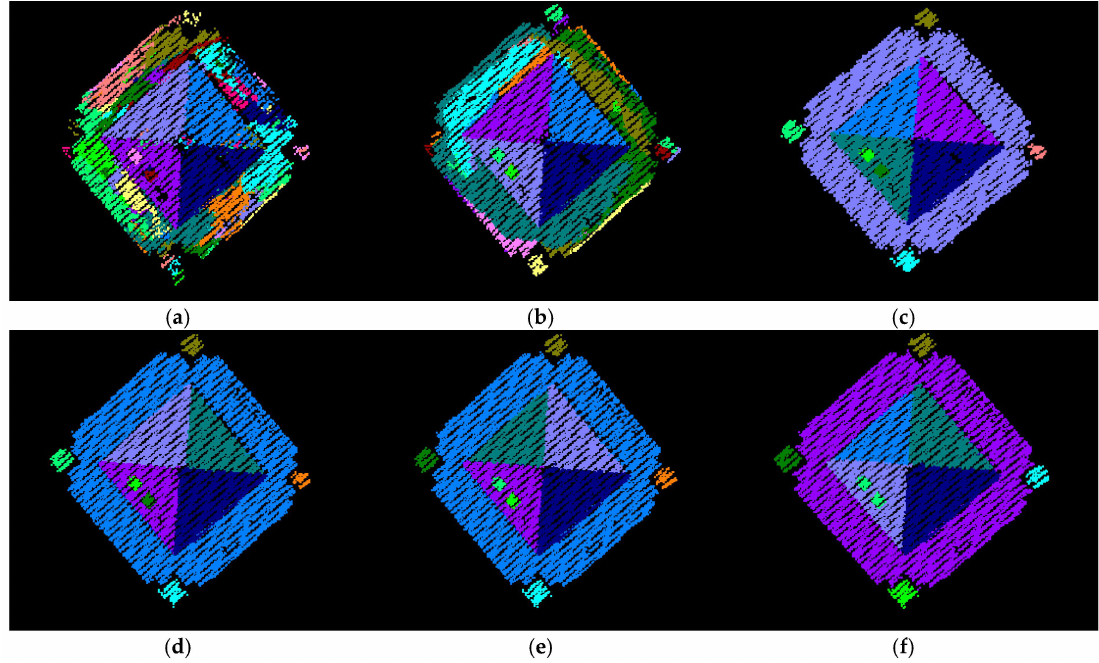
Figure 23. Segmentation results according to changing the accuracy of the laser data from 0.02 m to 0.30 m (searching radius is 2.0 m for all cases). The accuracy of the laser data: ( a ) 0.02 m; ( b ) 0.05 m; ( c ) 0.10 m; ( d ) 0.15 m; ( e ) 0.20 m; ( f ) 0.30